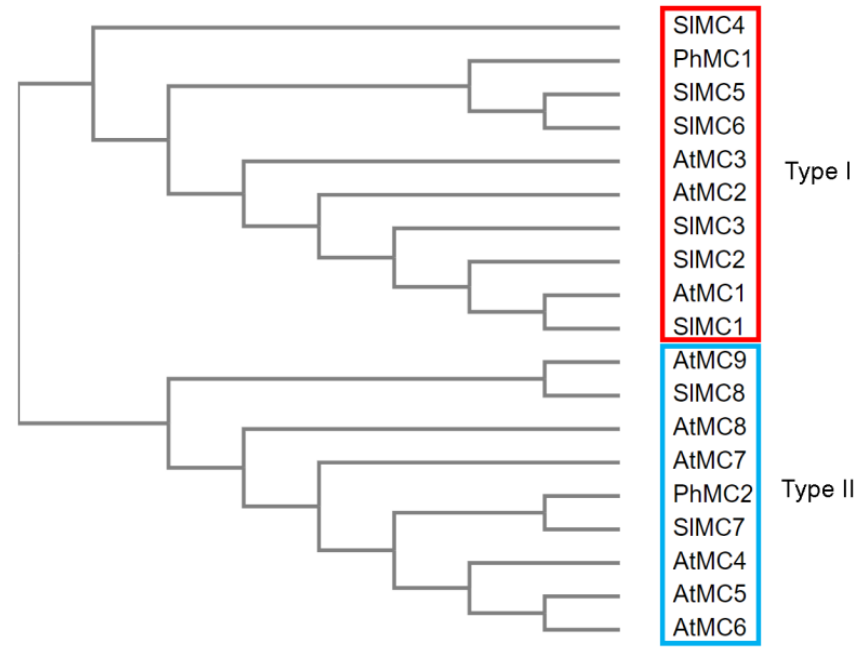
Figure 1. Neighbor-joining phylogenetic tree of type I (red box) and type II metacaspases (blue box). Amino acid sequences or the predicted protein translations are from petunia (PhMC1, Gen- Bank# AFK93070; PhMC2, AFK93071), Arabidopsis (AtMC1, GeneBank# NP_171719; AtMC2,